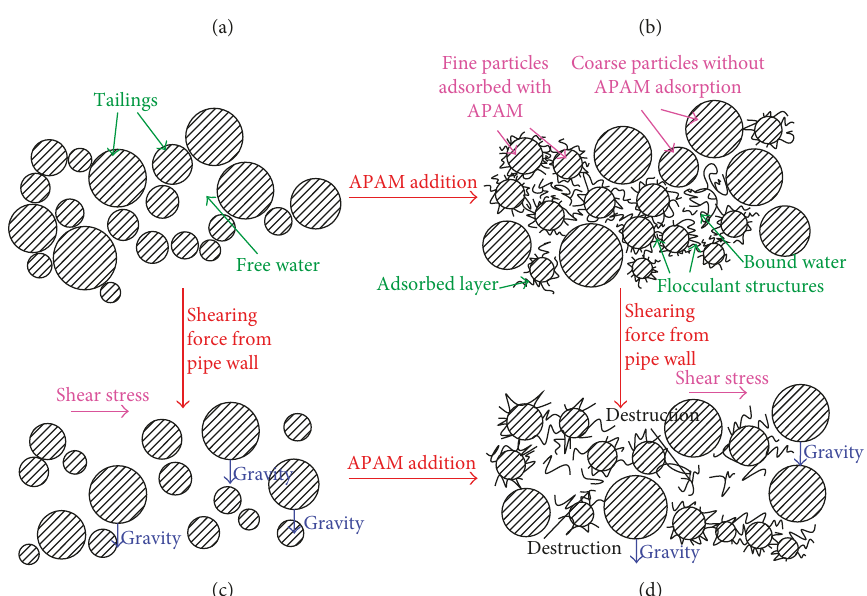
Figure 6: Evolution diagram of the action mechanism of APAM: (a) without shear stress and APAM addition; (b) without shear stress but with APAM addition; (c) under shear stress but without APAM addition; (d) under shear stress and with APAM addition.